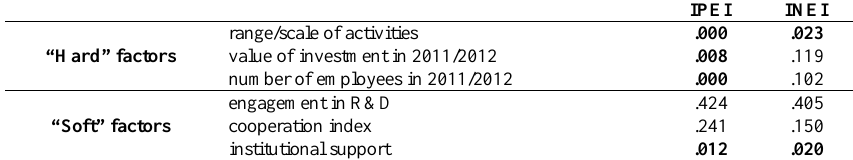
Table 4. P-value of H Kruskal-Wallis’ test for k independent samples (p values)